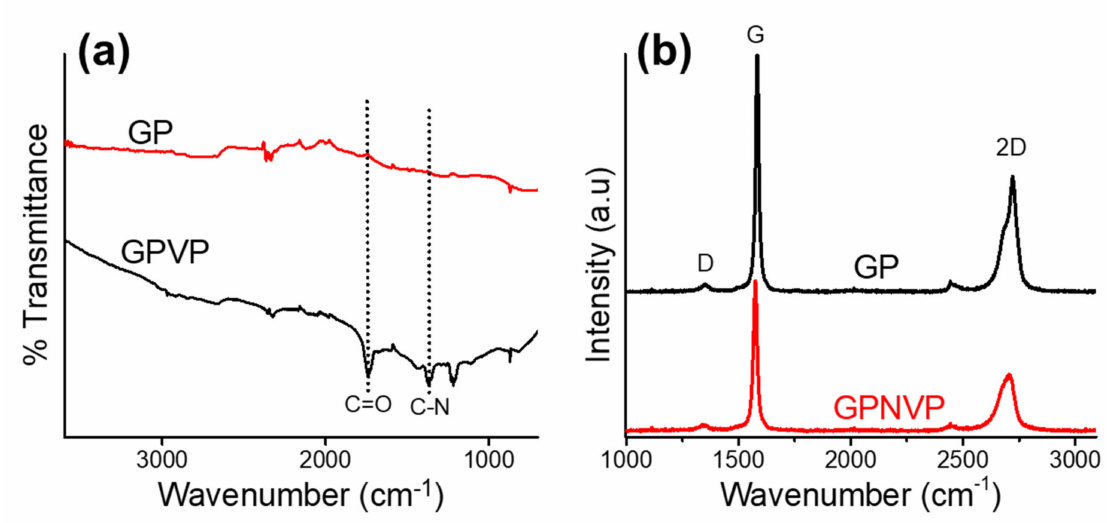
Figure 4. ( a ) Comparison of ATR-FTIR and ( b ) Raman spectra of graphite powder (GP) and GPNVP